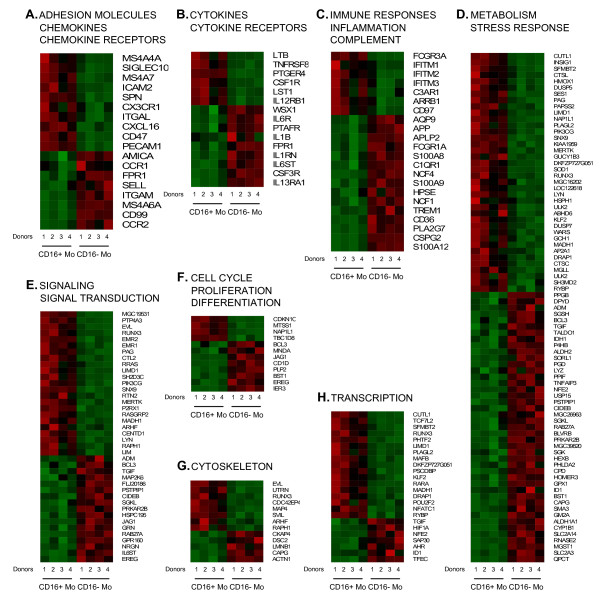
Biological functions of genes differentially expressed in CD16+ and CD16- monocytes. Differentially expressed genes were classified based on their biological functions using Gene Ontology as indicated. Heat maps were generated using dChip software and include data from matched CD16+ and CD16- Mo from 4 different individuals. In each heat map, upregulated genes are plotted first followed by downregulated genes. Red and green signify increased and decreased gene expression, respectively.